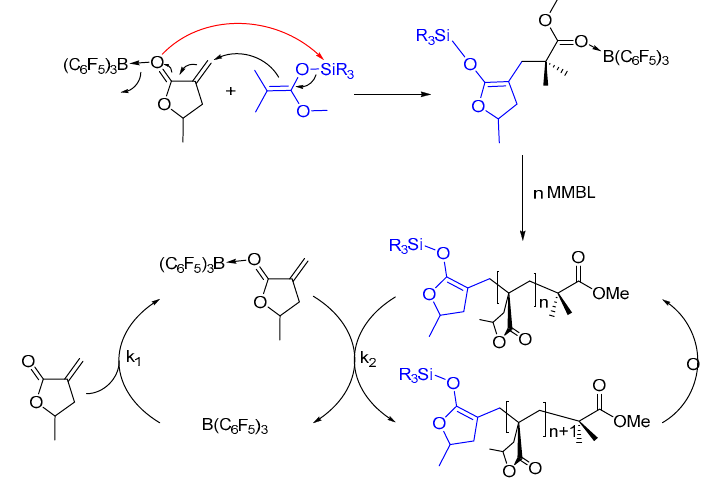
Table 2. B(C 6 F 5 ) 3 -catalyzed copolymerization of MMBL and MBL by i Bu SKA/B(C 6 F 5 ) 3 system a . Run No. M1/M2 Conv. b (%) M w c (kg/mol)